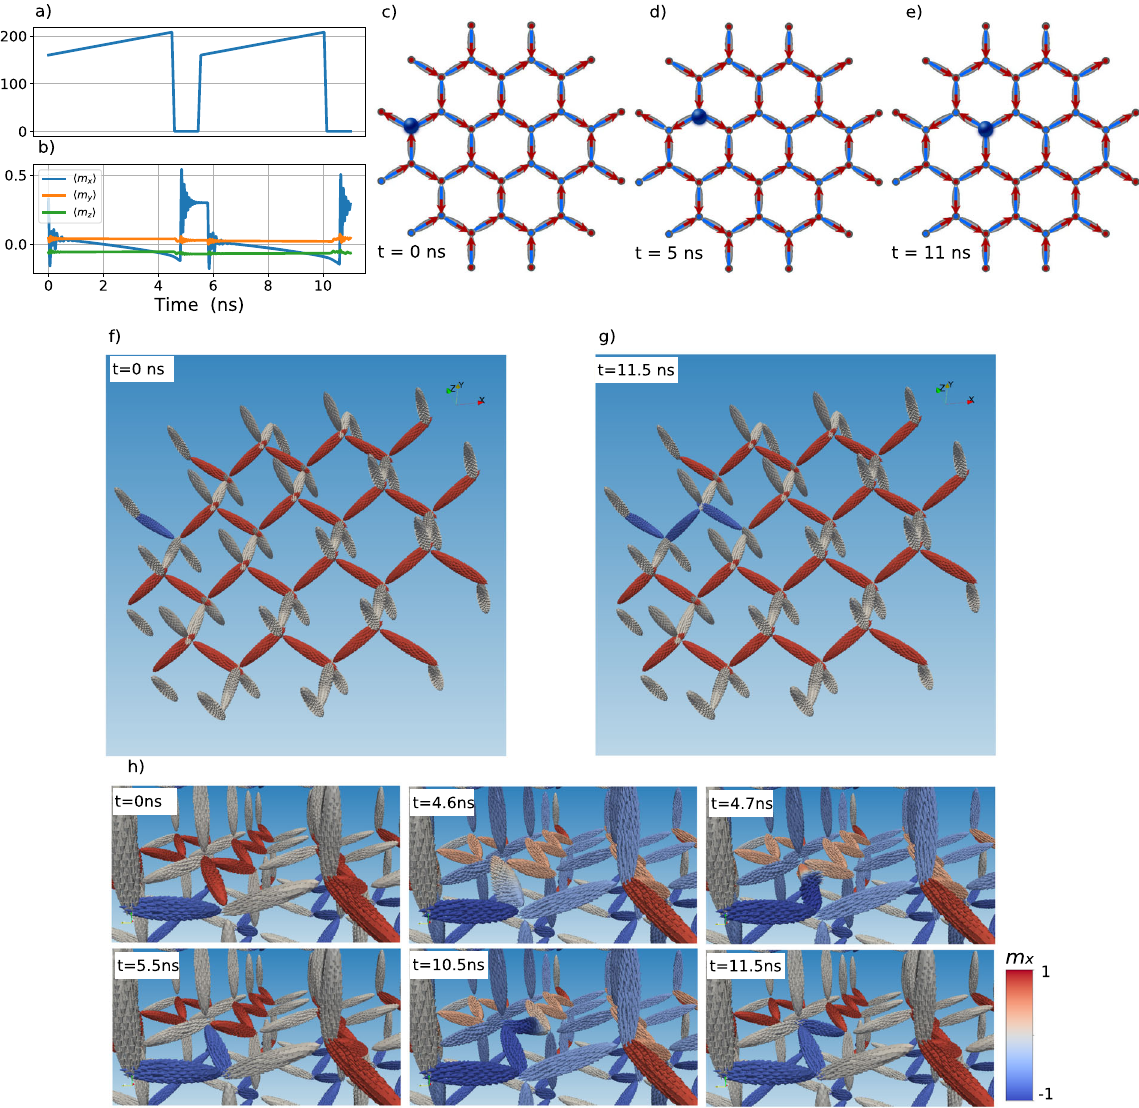
Fig. 4 Field-driven monopole propagation. Temporal evolution of the magnitude of the applied fi eld ( a ) and of the averaged magnetization components ( b ) within the bulk layer during the x -propagation. The fi eld is applied along − x in order to maximize the Zeeman energy acting on the ellipsoid whose magnetization should be switched. The fi eld is turned off after t = 4.8 ns in order to transfer the magnetic charge to the next vertex controlling the propagation. c – e Schematic illustration of the monopole (dark blue) propagation. f – h Snapshots of the magnetization states from the output of the conducted micromagnetic simulations, where f illustrates the initial and g the fi nal magnetic con fi gurations. The magnetization evolution during the simulations is depicted at different times (white boxes) in ( h ). Color in f – h shows the x -component of the magnetization, as given by the